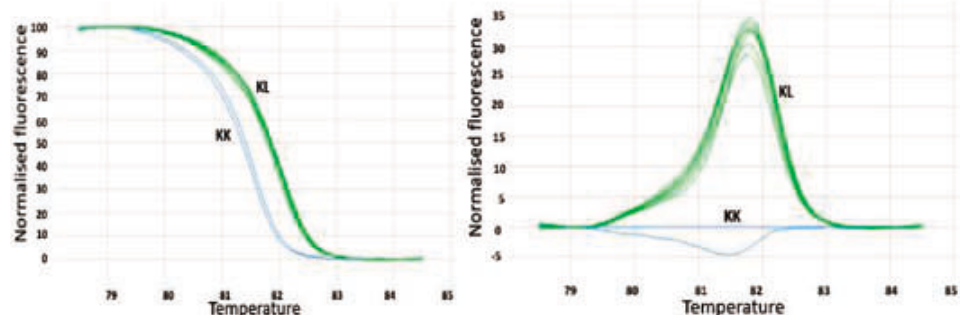
that the population was not in Hardy-Weinberg equilibrium (p≤0.05). Natural selection may be going on favouring the K allele in crossbred cattle population. However, the status of HW equilibrium has to be further examined in a larger